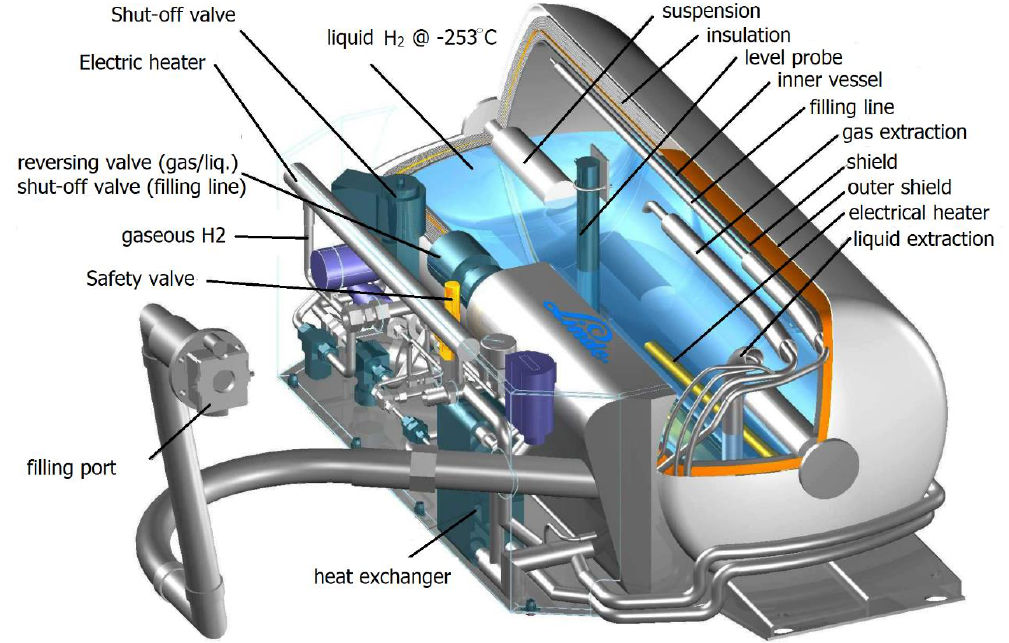
Figure 15. Schematic of a cryogenic hydrogen tank (source: Linde ®